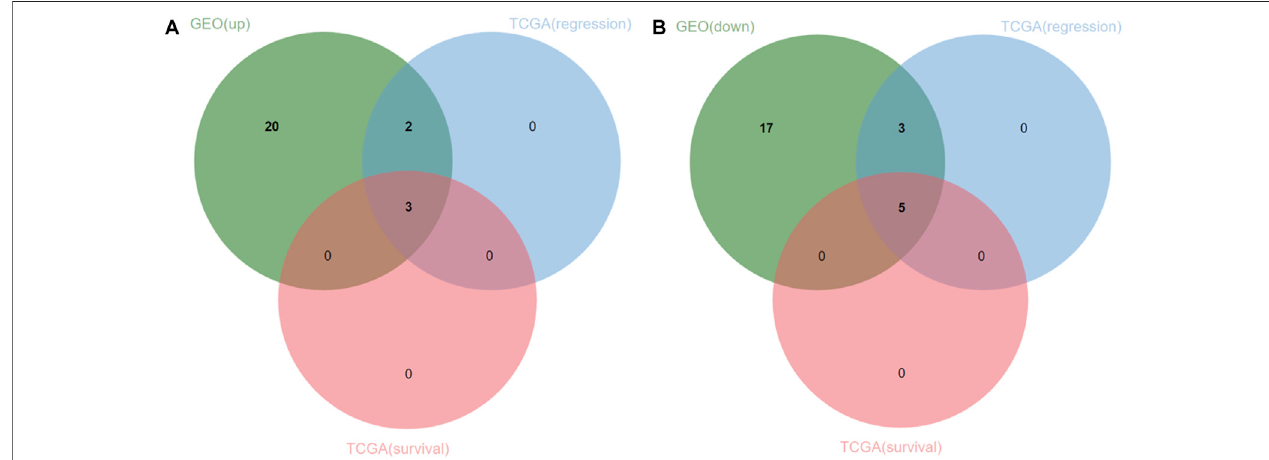
FIGURE 6 | Venn diagram of 25 upregulated and downregulated DEGs and TCGA datasets. (A) three upregulated genes (oncogenes) were identi fi ed. (B) fi ve downregulated genes (tumor suppressor genes) were identi fi ed.